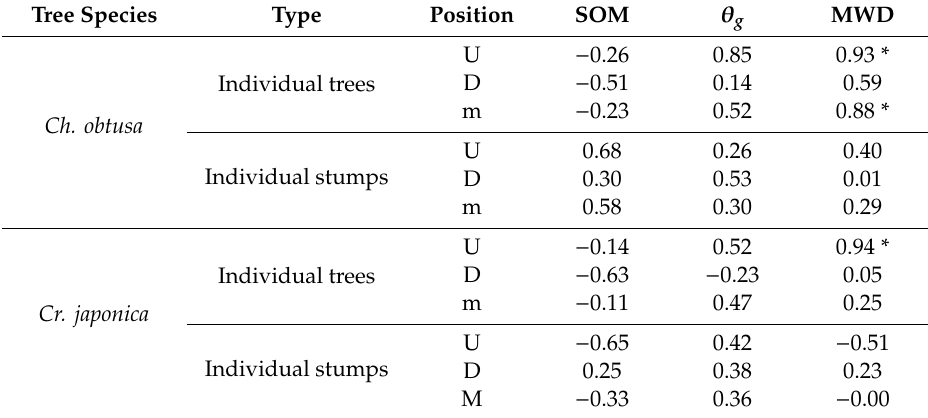
Table 3. Pearson correlation coe ffi cient ( r ) between soil water repellency (SWR) and soil properties (SOM, θ g and MWD) upslope and downslope of individual Chamaecyparis obtusa and Cryptomeria japonica trees and